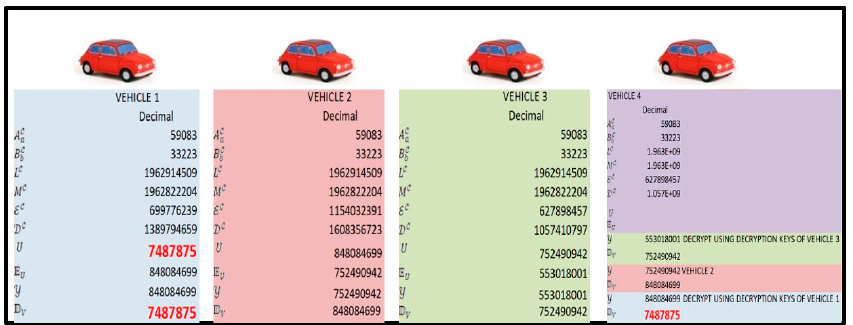
Figure 6. Example for CRSA.